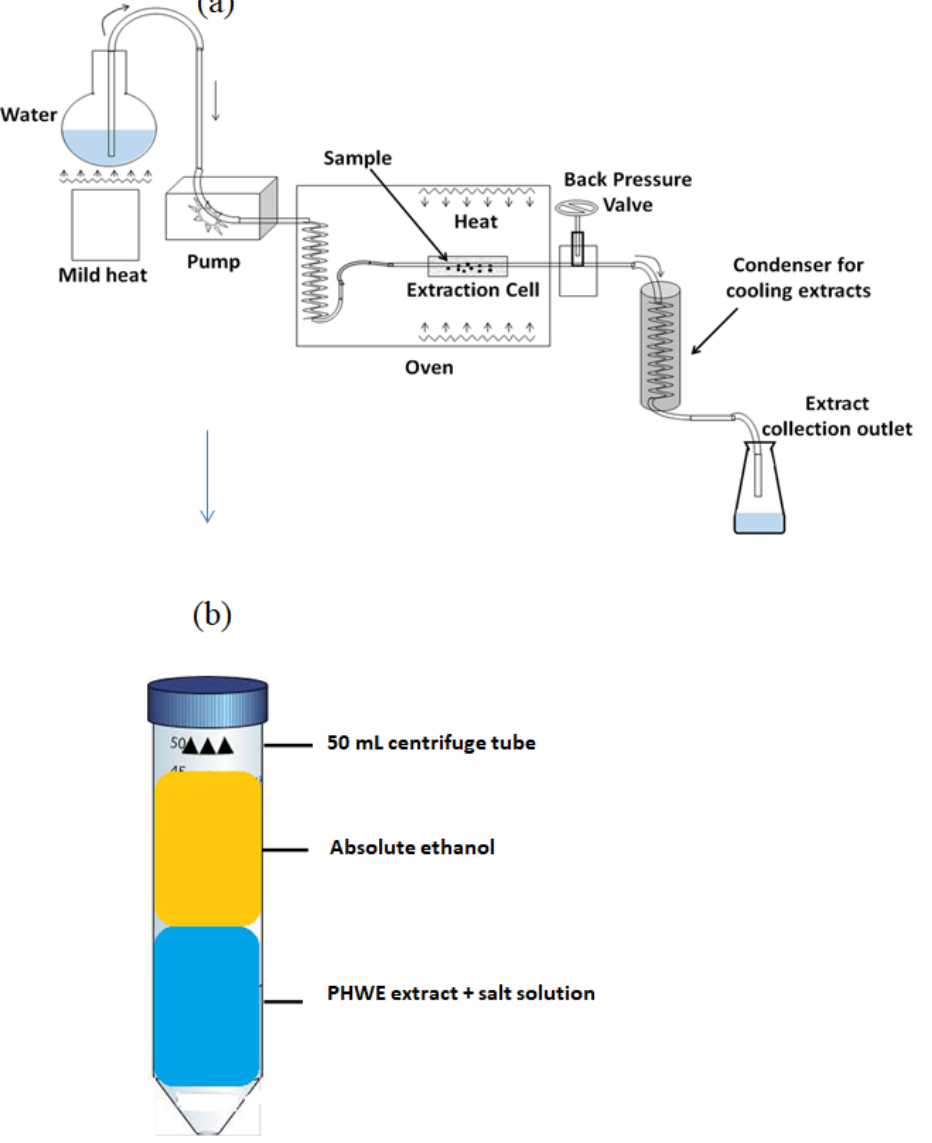
Figure 1. ( a ) A PHWE extraction system was consisting of the inflowing water propelled by a pump into the extraction cell. The metabolites contained in water were then cooled within the condenser before being collected in the Erlenmeyer flask. ( b ) A PHW-ATPE set-up.